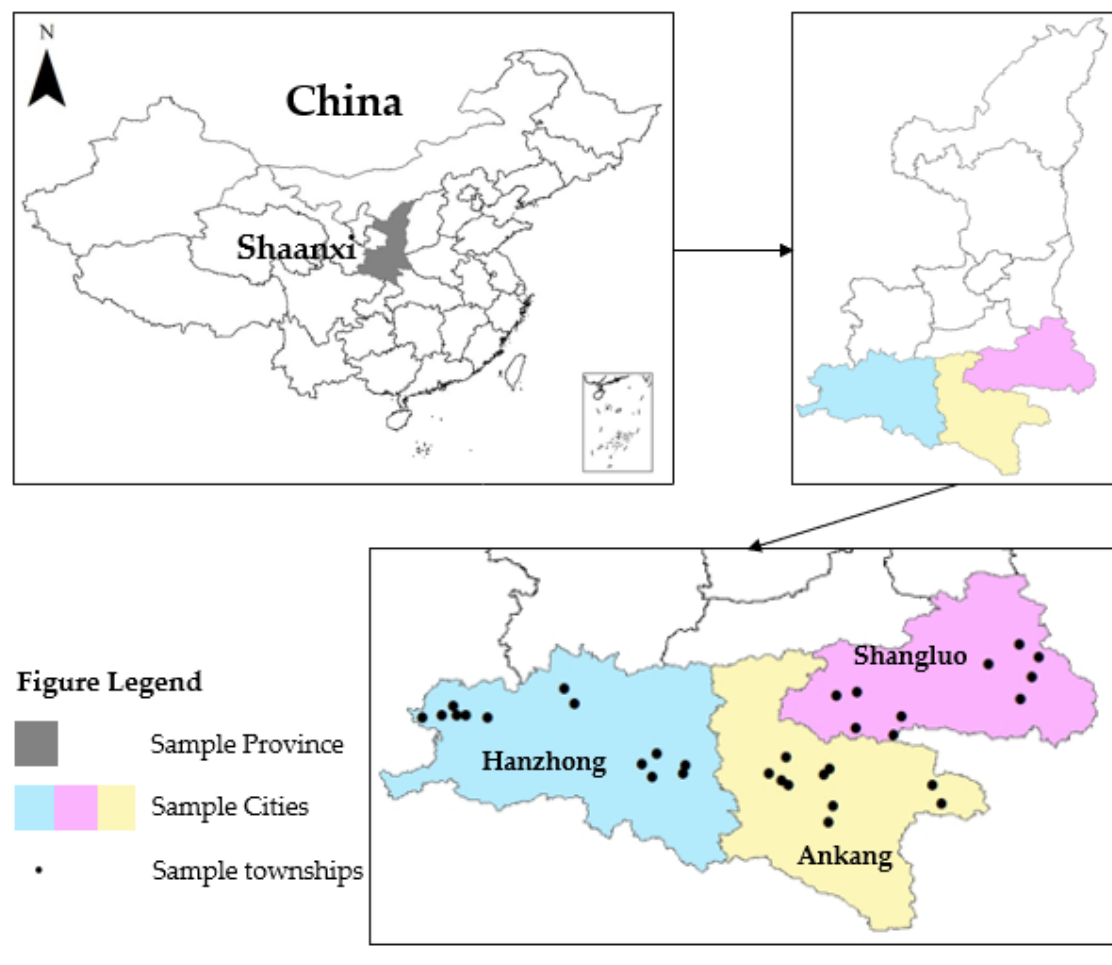
Figure 2. Study area location.